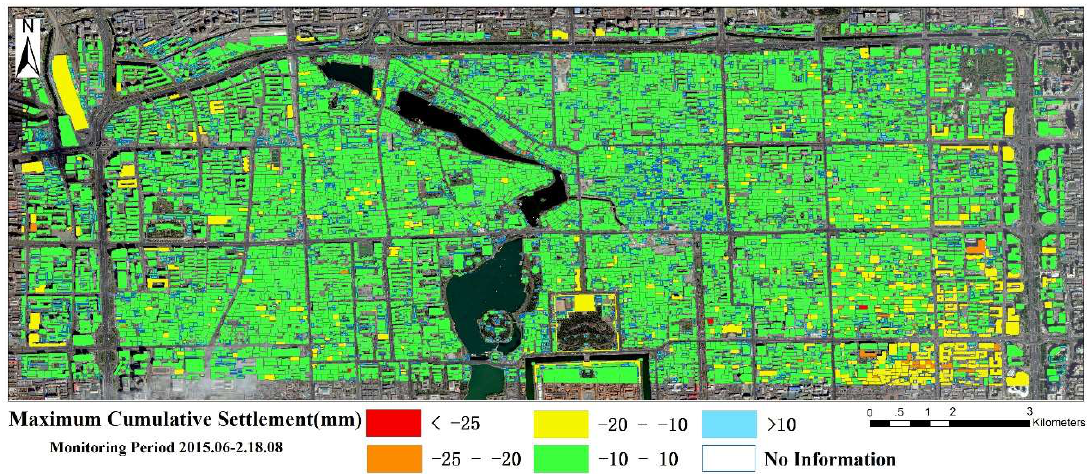
Figure 15. Maximum measured settlement values of all buildings in the analyzed area.